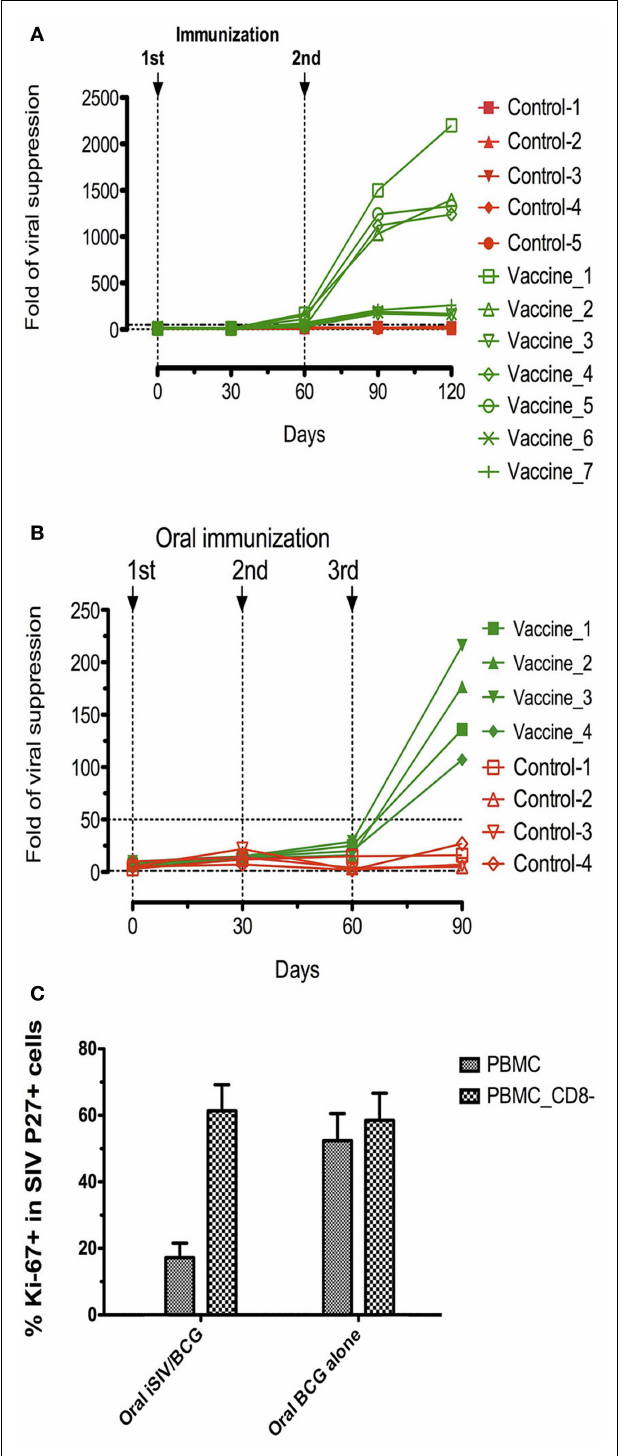
FIGURE 2 | Ex vivo antiviral activity and suppression of SIV positive CD4 + T-cell activation generated by vaccine-induced CD8 + T-cells of rhesus macaques immunized with inactivated SIV and BCG . (A,B) Ex vivo antiviral activity generated by vaccine-induced CD8 + T-cells in